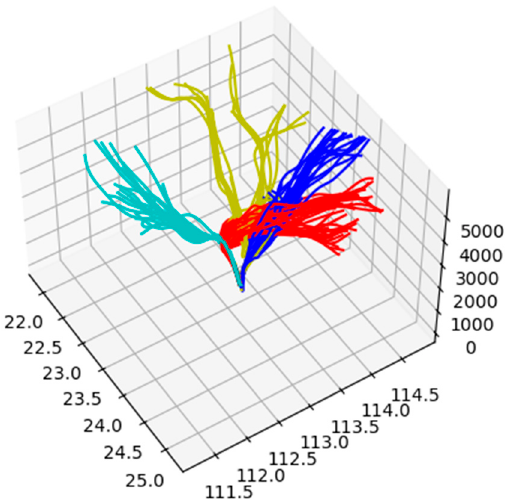
Figure 12. DTW + DBSCAN clustering result.